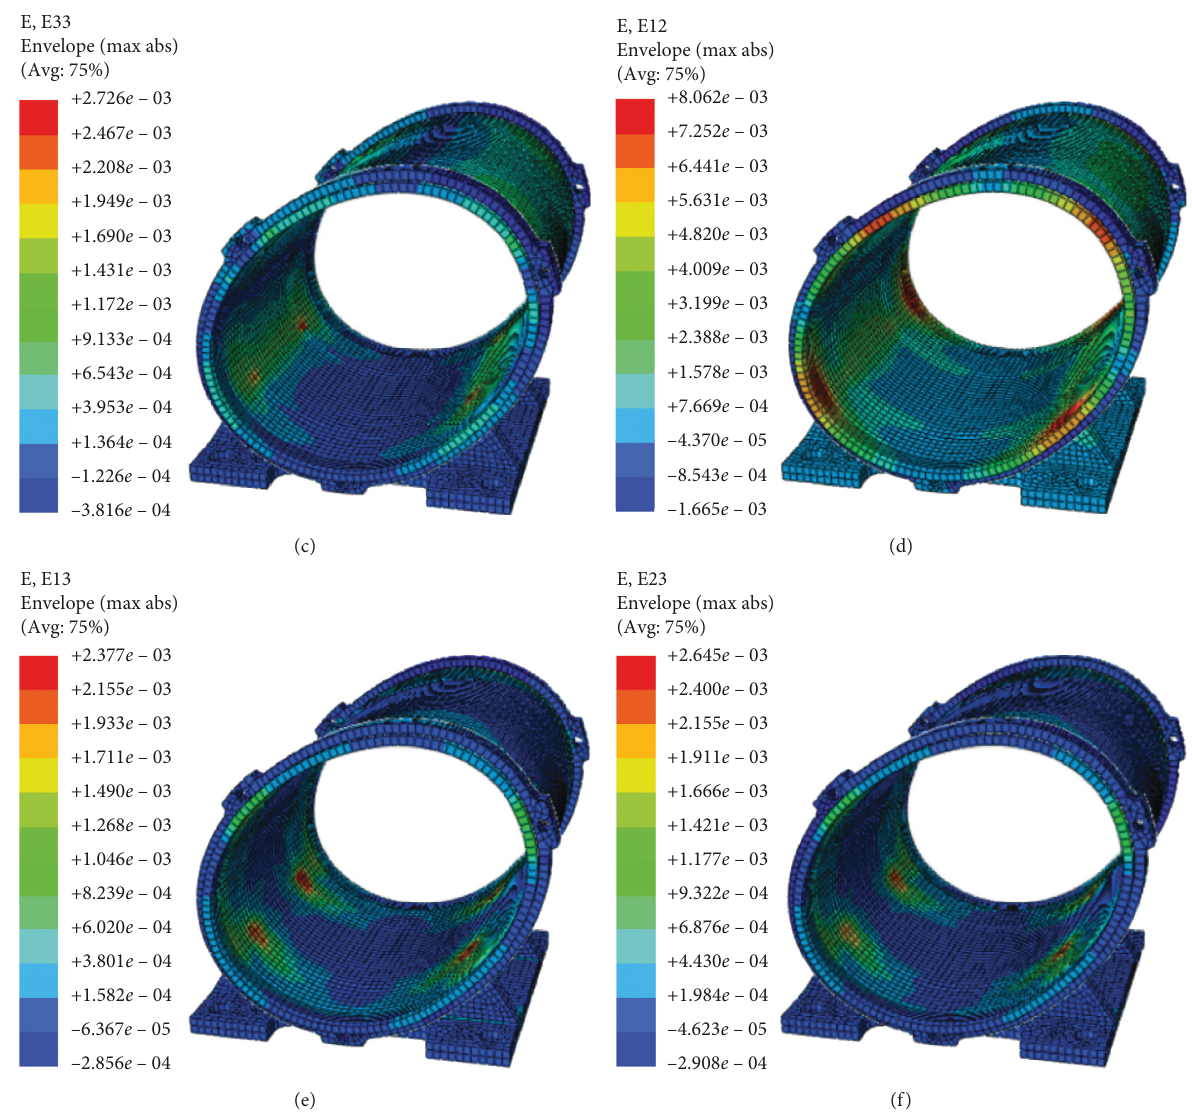
Figure 5: Strain components of the CFRP motor frame in all directions in the first mode. (a) 11-directional strain component, (b) 22- directional strain component, (c) 33-directional strain component, (d) 12-directional strain component, (e) 13-directional strain com- ponent, and (f) 23-directional strain